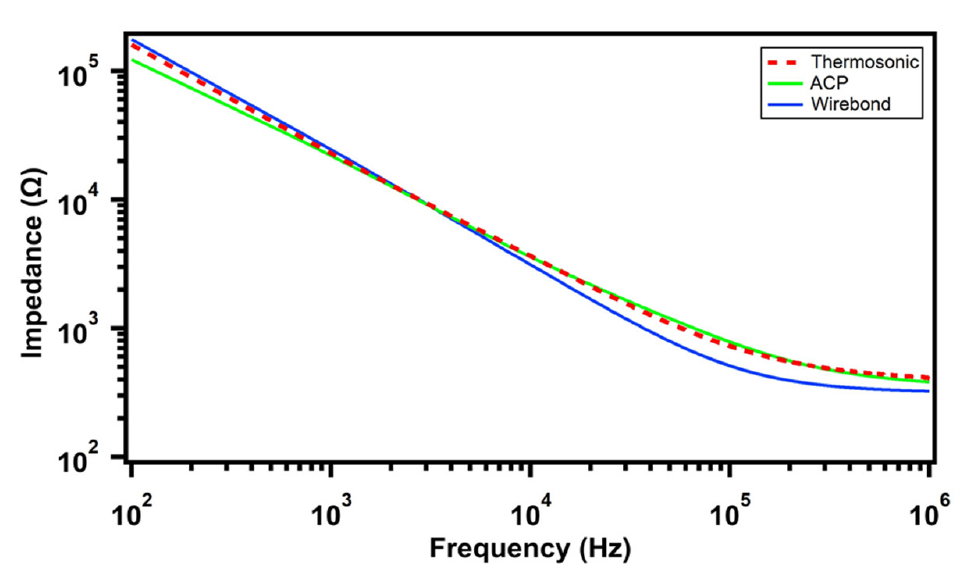
Figure 7. Wire-bonded (WB) sensor package in comparison to flip-chip thermosonc and ACP pack- ages; initial reading implying similar behavior.